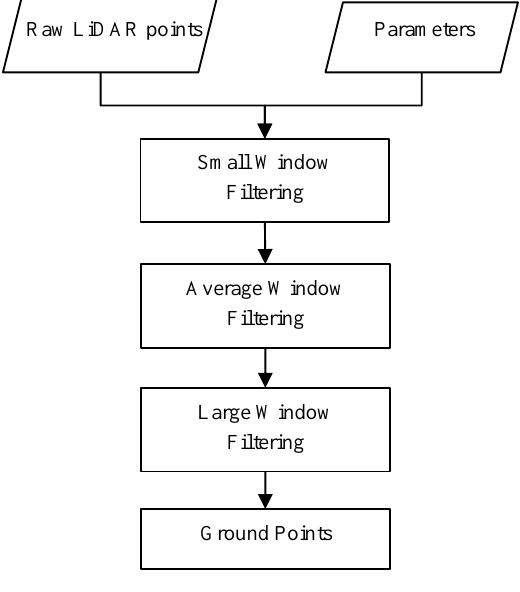
Figure. 2. Multi-Scale Analysis of height difference